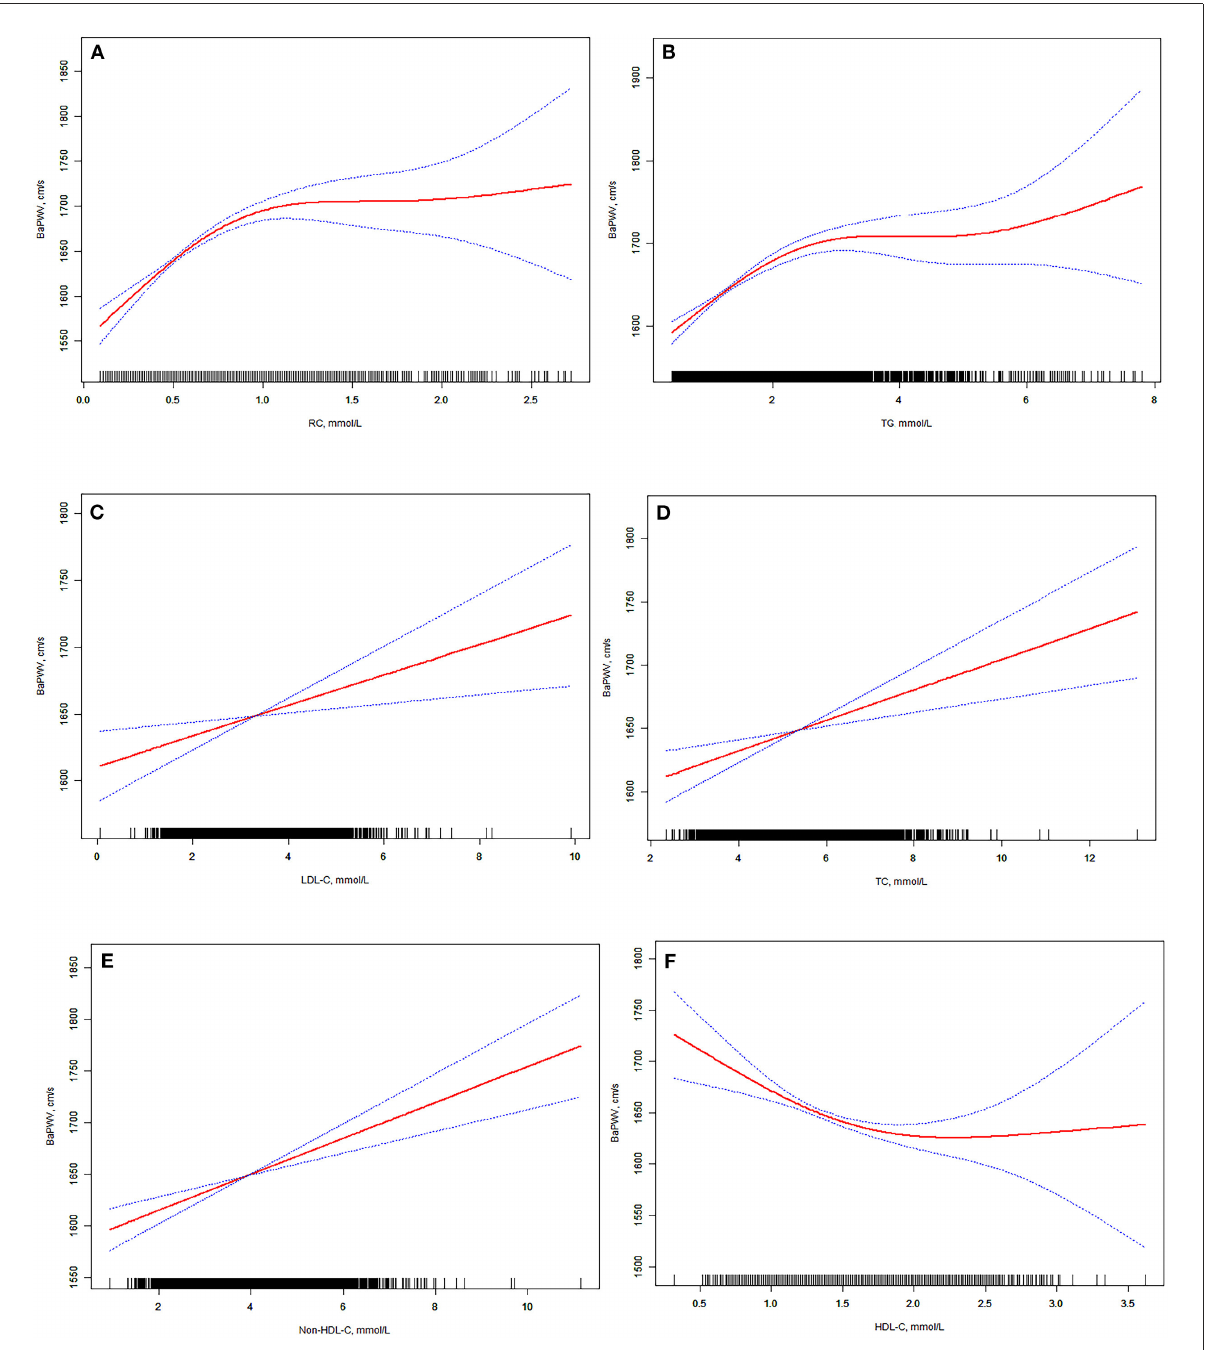
FIGURE1 (A–F) Associations between brachial-ankle pulse wave velocity and lipid profiles. We conducted restricted cubic spline curves to evaluate non-linear relationship between lipids and baPWV. After adjustment for covariables including sex, age, BMI, eGFR, smoking, drinking, hypertension history, diabetes history, myocardial infarction history, and stroke history, the significant associations between lipid profiles and baPWV remained statistically significant. 95% confidence interval is shown in blue. BMI, body mass index; eGFR, estimated glomerular filtration rate; CI, confidence interval; baPWV, brachial-ankle pulse wave velocity; TC, total cholesterol; TG, triglyceride; HDL-C, high-density lipoprotein cholesterol; LDL-C, low-density lipoprotein cholesterol; RC, remnant